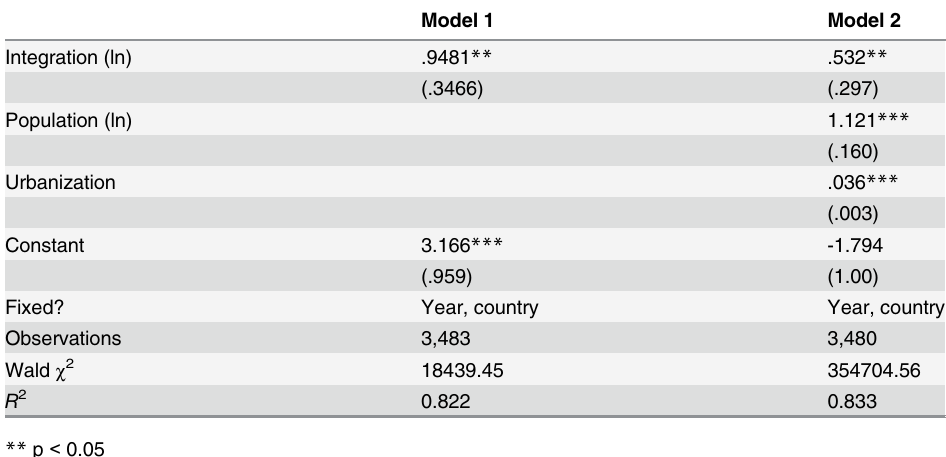
Table 3. Countries ’ Normalized Efficiency Level Regressed on their Level of